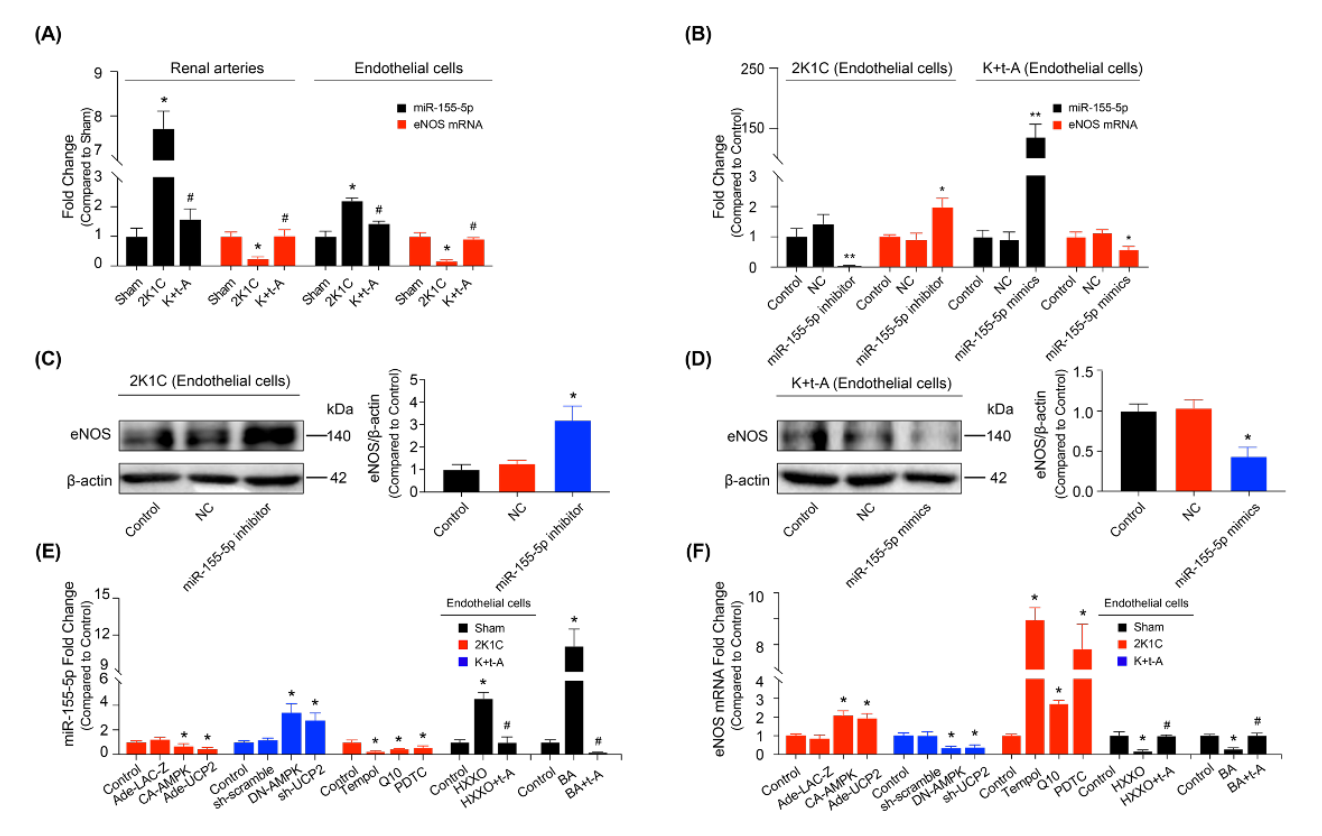
Figure 6. MiR-155-5p was involved in the regulation of eNOS. The miR-155-5p and eNOS mRNA levels in the renal arteries and endothelial cells from Sham, 2K1C, and 2K1C + t-AUCB (K + t-A) rats ( A ). The effects of the miR-155-5p inhibitor and mimics on the levels of miR-155-5p and eNOS mRNA in the renal endothelial cells from 2K1C or 2K1C + t-AUCB groups ( B ). The eNOS expression in the 2K1C rat renal endothelial cells transfected with miR-155-5p inhibitor ( C ), and that in 2K1C + t-AUCB rat endothelial cells treated with miR-155-5p mimics ( D ). The contents of miR-155-5p ( E ) and eNOS mRNA ( F ) in the three groups of rat renal endothelial cells under different treatments. n = 4–6 per group. Data are presented as mean ± SEM. * p < 0.05, ** p < 0.01 vs. Sham or respective control; # p < 0.05 vs. 2K1C, HXXO (hypoxanthine plus xanthine oxidase), or BA.